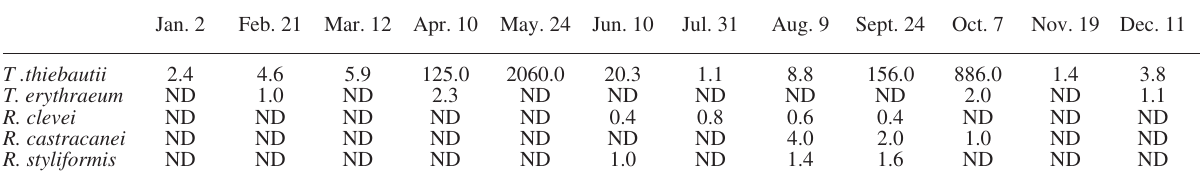
Table 2. – Composition and abundance (10 3 trichomes m -2 ) of planktonic nitrogen fixing cyanobacteria at fixed station s03 in 2003 (nd means not detected). Jan.